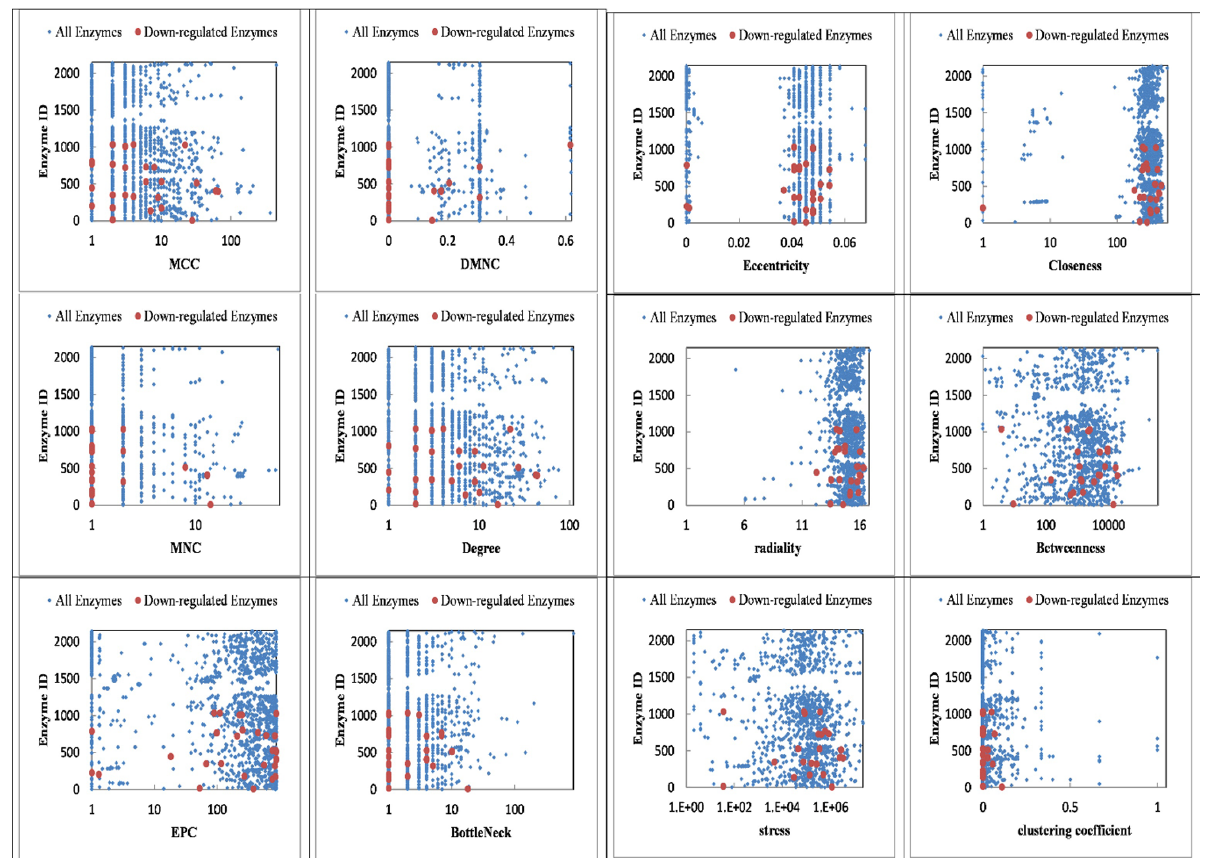
Figure 3. Shows the distribution of down-regulated enzymes in enzyme-centric network of yeast in H4 substituted tail model. The x- and y-axis indicate the centrality score and the enzyme ID of the H4 substituted tail model, respectively.